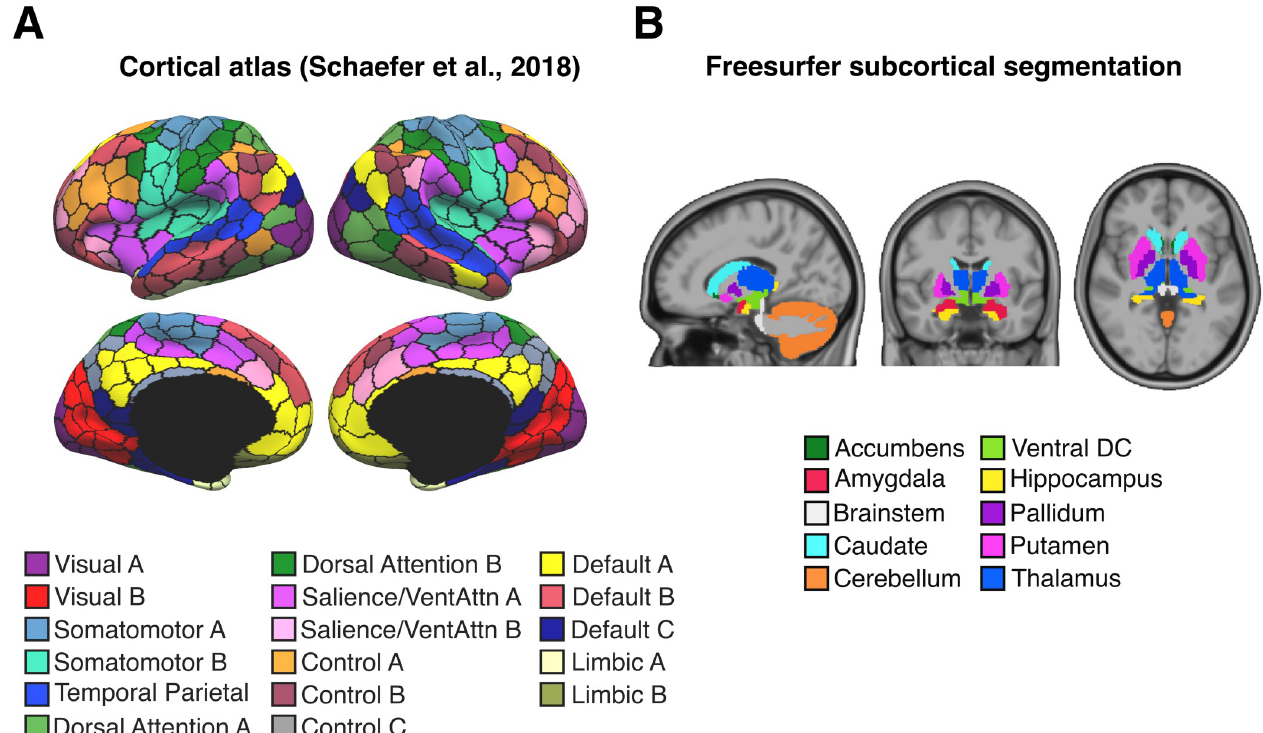
Fig 4. Four hundred nineteen ROIs. (A) Four hundred–area cortical parcellation in fs_LR surface space [45]. Parcel colours correspond to 17 large-scale networks [47]. Image reproduced under a CC BY 4 . 0 license , credit : https : //doi . org/10 . 6084/m9 . figshare . 10062482 . v1 (B) Nineteen subcortical regions defined in participant-level volume space [46]. Image reproduced under a CC BY 4 . 0 license , credit : https : //doi . org/10 . 6084/m9 . figshare . 10063016 . v1 .DC, diencephalon; ROI, region of interest; VentAttn, ventral attention.